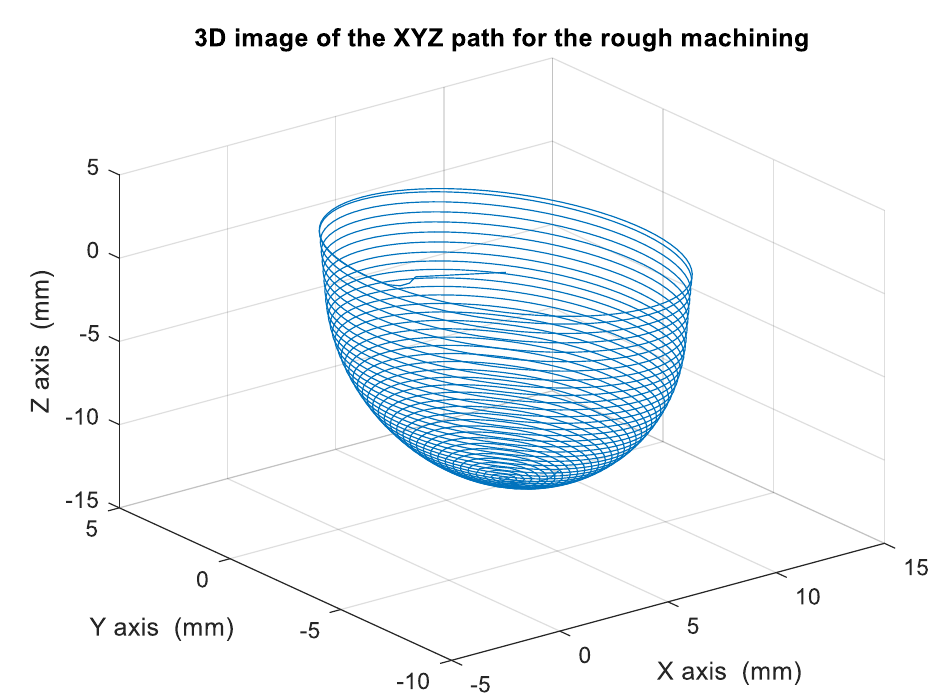
Figure 20. Three-dimensional image of the XYZ path after converting the rough machining program.